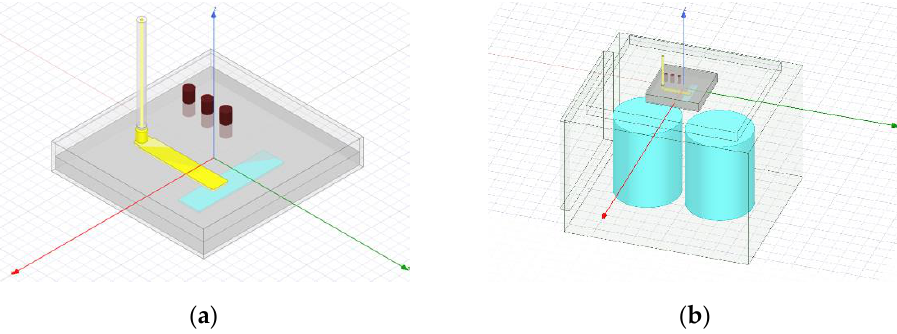
Figure 1. ( a ) Model of the slot antenna fed by a stripline. Each of the elements described above can be seen; ( b ) Antenna modelled feeding a box with commercial microwave oven dimensions and loaded with 2 L of fresh water.